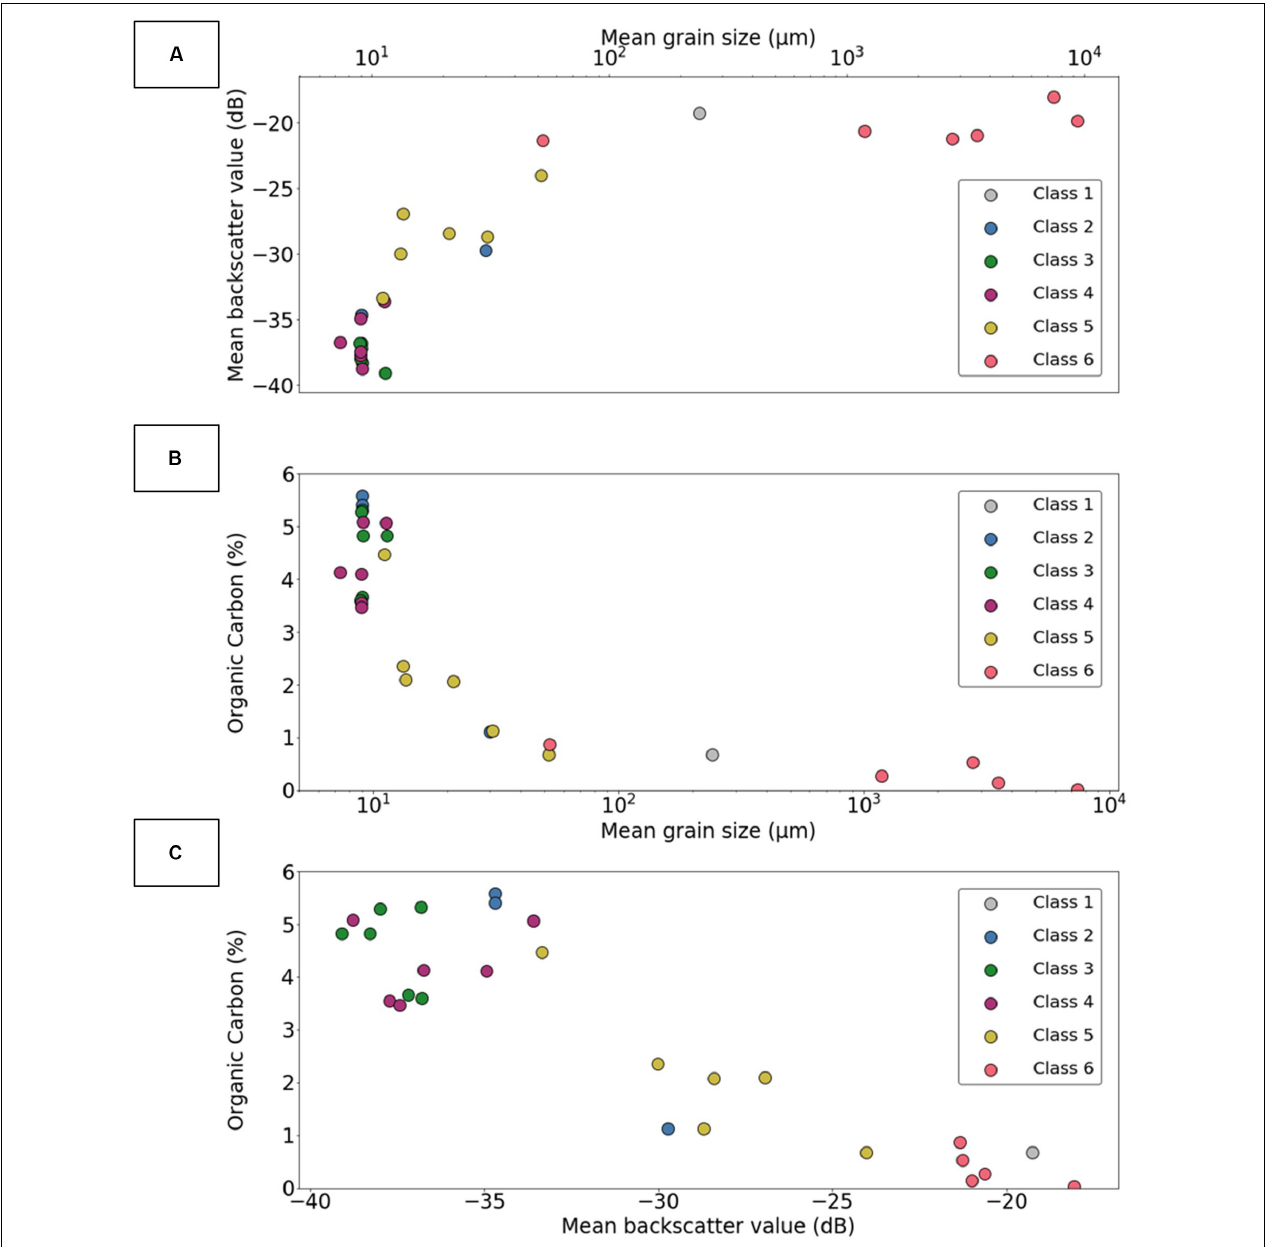
FIGURE 8 | Scatterplots showing the relationships between (A) mean grain size, x ( µ m) and mean backscatter intensity, y (dB) [logarithmic; y =2.68 ln( x ); r 2 = 0.74], (B) mean grain size, x ( µ m) and organic carbon content, y (%) (power; y =15.02 x - 0 . 6 ; r 2 = 0.87) and (C) organic carbon content, y (%) and mean backscatter intensity, x (dB) (linear; – y = –0.2506 x –4.797; r 2 = 0.82) for each grab sample from Loch